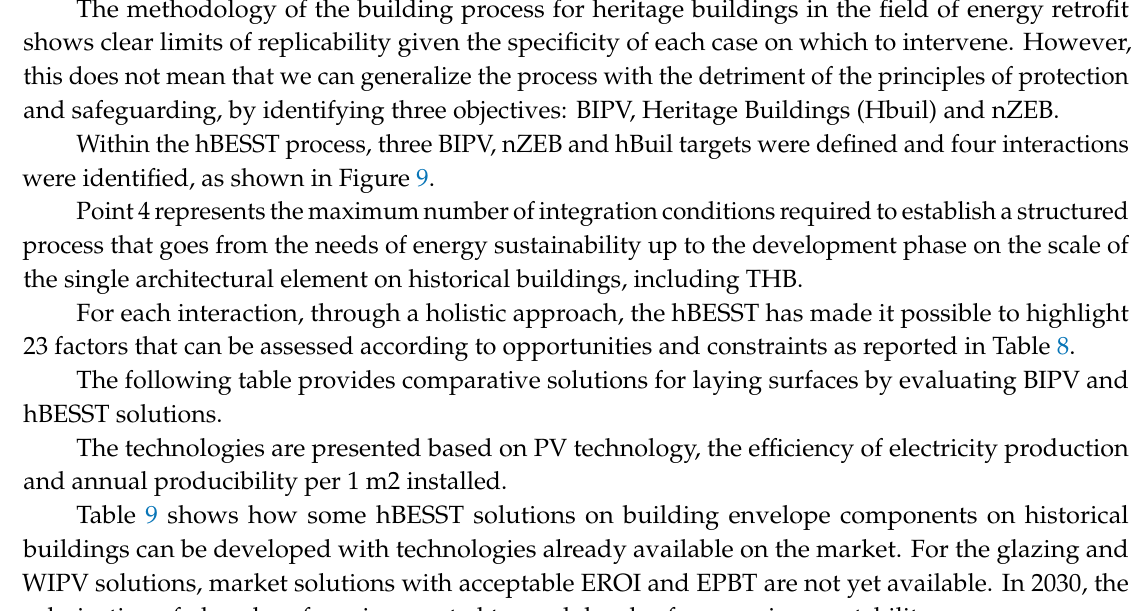
Table 7. Approaches and criteria within the Heritage Building Management Process for different BIPV solutions.